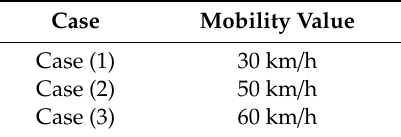
Table 5. Mobility value for each considered case.